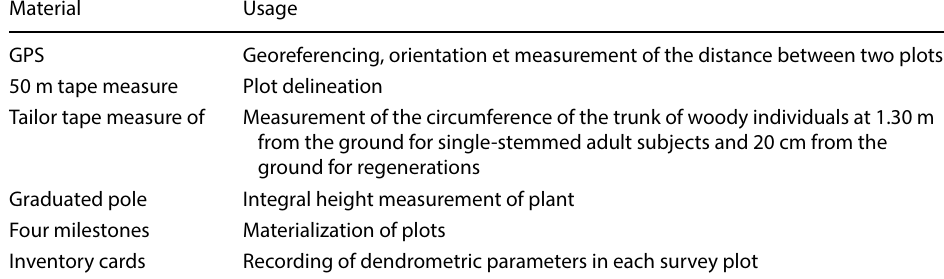
Table 1 Material used for data